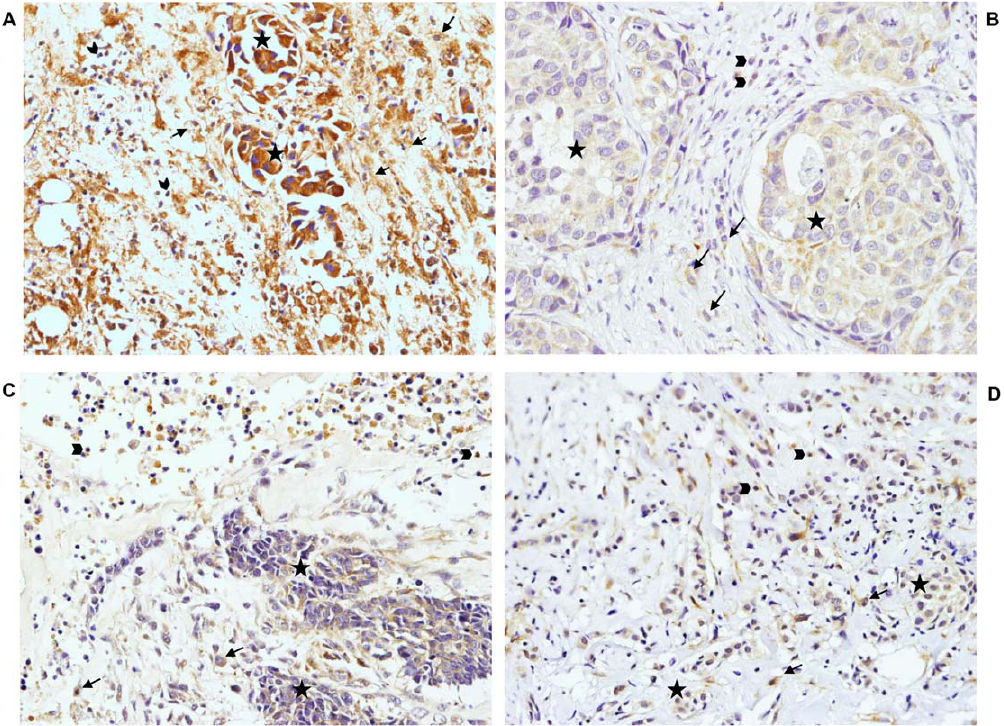
Figure 3. Representative example of immunostaining. MMP11 (A) and TIMP2 (B) immunostaining at the tumor center and MMP9 (C) and MMP14 (D) at the invasive front ( 6 200 magnification), indicating the different cell types. Tumor cells ( w ), lymphocytes ( ) and macrophages ( ).